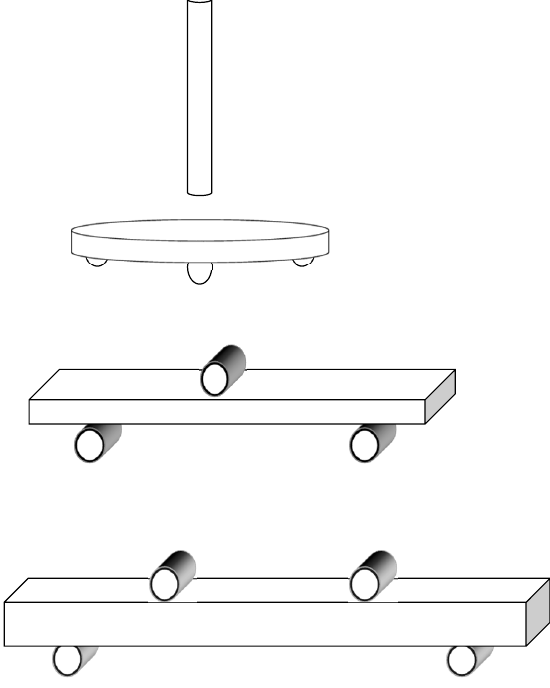
Figure 1. Schematic set up of biaxial; 3 ‐ point; 4 ‐ point test method.